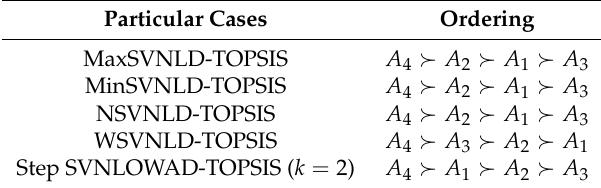
Table 11. Ordering of the alternatives based on particular cases of the SVNLOWAD-TOPSIS